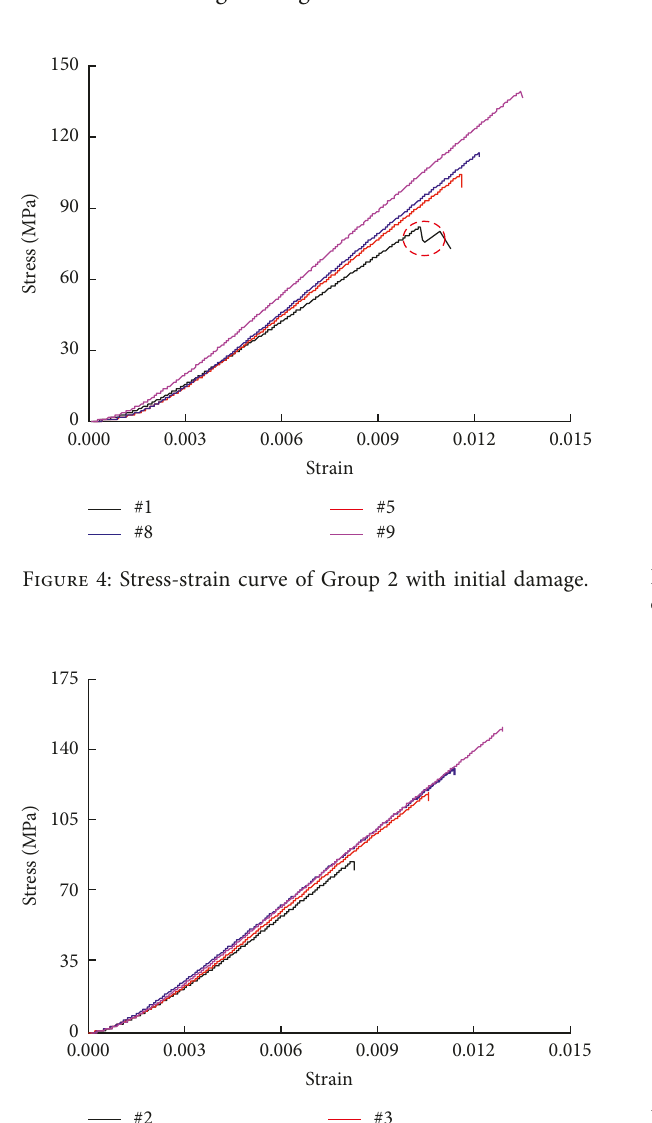
Figure 7: Relationship between the loading rate and deterioration